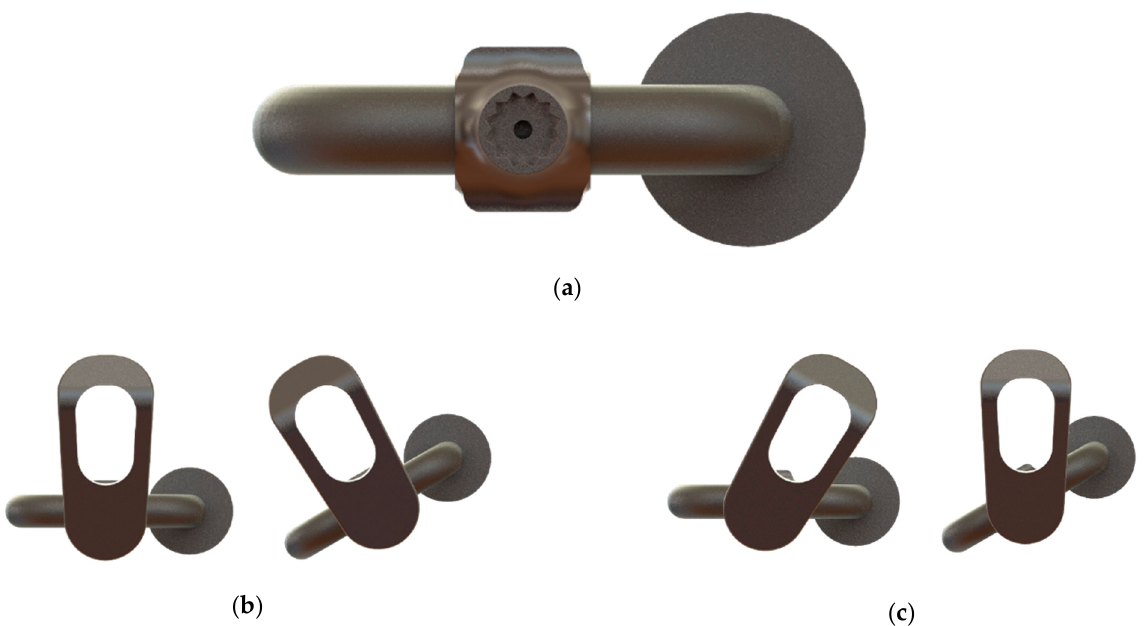
Figure 7. Leaf positioning system: ( a ) angular discrete coupled system; ( b ) initial vertical position of the leaf with a final inclination; ( c ) inclination initial position of the leaf with a final vertical position.